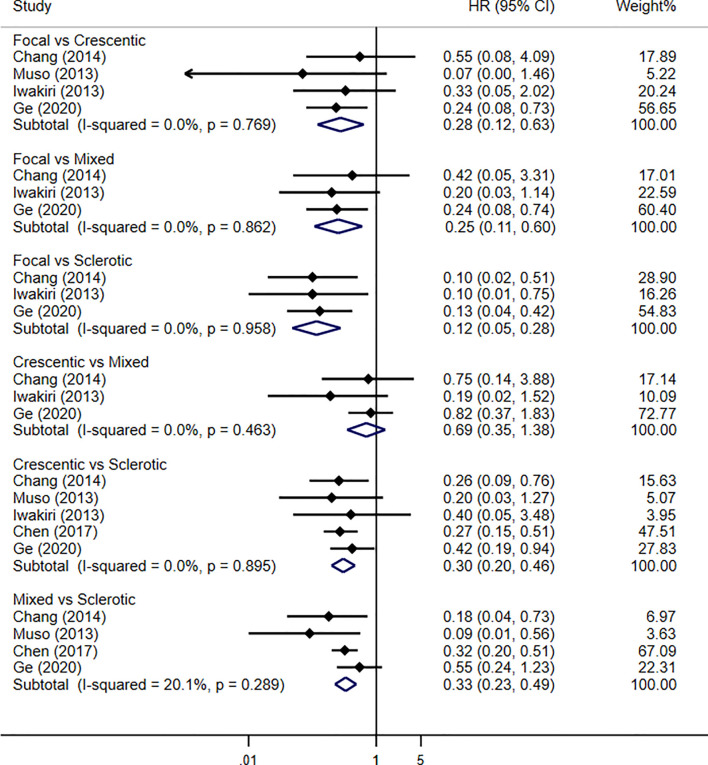
Pooled hazard ratios for renal survival using Berden histopathologic classification in MPO-ANCA-GN patients by traditional meta-analysis.